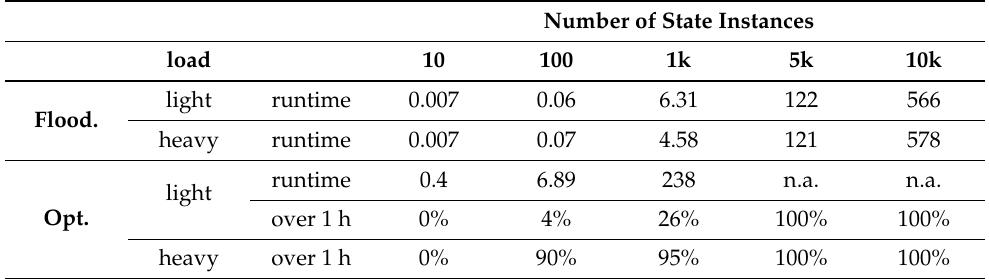
Table 5. The average run time of placement algorithms in seconds, and the percentage of simulations exceeding the one hour time-limit. Opt. represents the Integer Linear Programming (ILP)/QP problem-solver CPLEX, while Flood. denotes our Flooding heuristics.